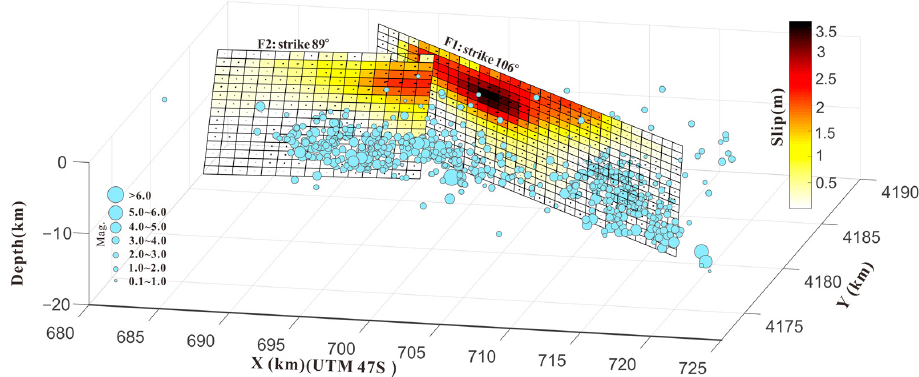
Figure 5. The slip model of the rupture faults of the 2022 Menyuan earthquake. The blue points represent the mainshock and 584 aftershocks through 17 January 2022 (1 with M ≥ 5, 5 with 4.0 ≤ M ≤ 4.9, 19 with 3.0 ≤ M ≤ 3.9, and 559 with M < 3).